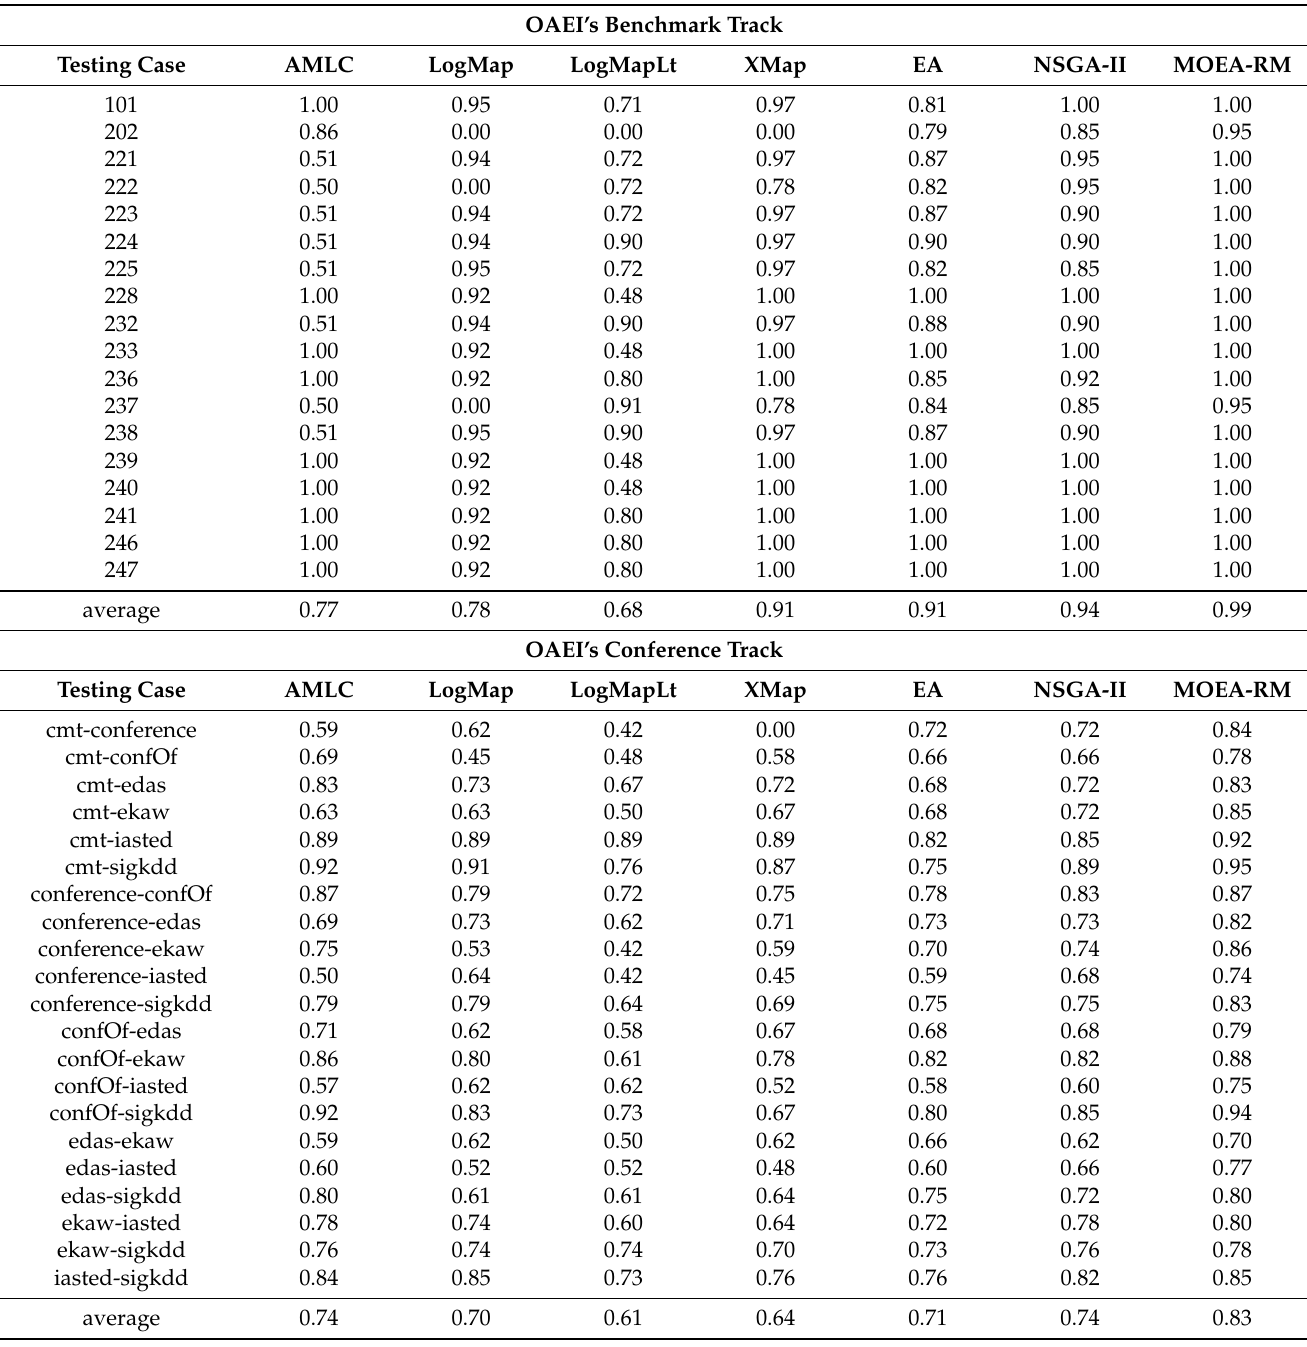
Table 3. Comparison in terms of